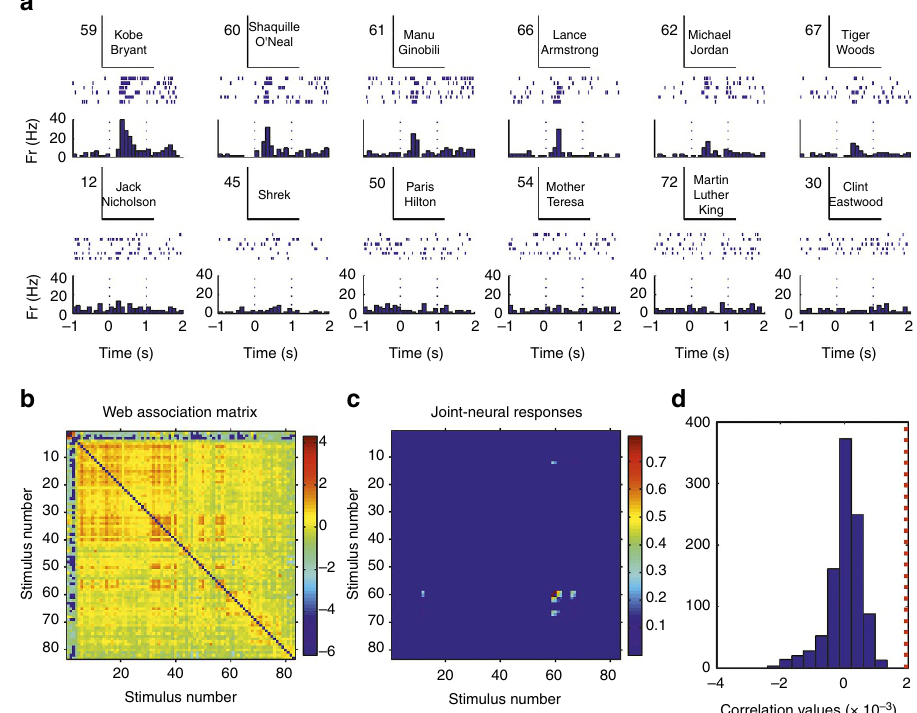
Figure 6 | Correlation analysis with a neuron in the hippocampus. ( a ) A single neuron in the hippocampus that fired to pictures of basketball players and to other sportsman. ( b , c ) Web-association and joint-neural response matrices (see text for details). Colour bars on the right denote association and join- response strength, respectively, in arbitrary units. ( d ) Correlation between the web-association and joint-response matrices (red dotted line) and for a distribution of 1,000 surrogates, which were obtained by randomly shuffling the responses (see text). The original correlation value was significantly larger than chance (rank test compared with the population of the 1,000 surrogates) with P o